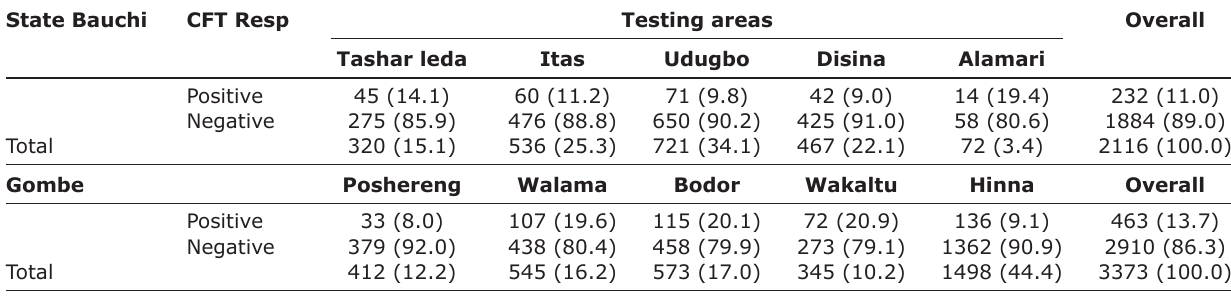
Table-1: Distribution of suspected bovine tuberculosis in five testing areas in Bauchi and Gombe States. State Bauchi CFT Resp Testing areas